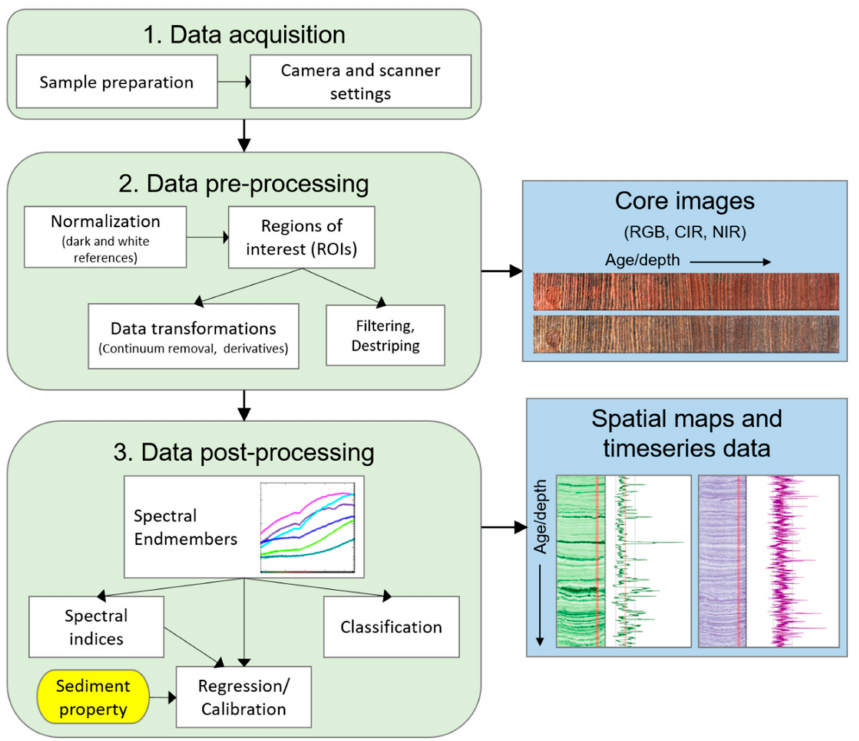
Figure 2. Schematic summary of a typical methodological workflow for hyperspectral imaging analysis of lake sediment